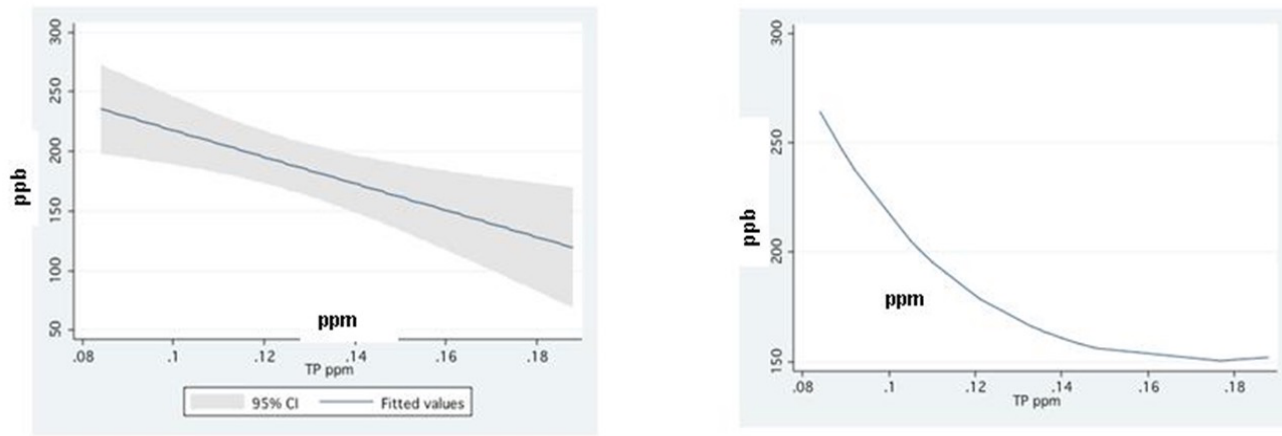
Figure 11. Annual averages of total phosphorus (TP) concentrations. In the Agmon effluent (ppb) vs. annual concentrations of TP in Jordan waters (ppm): linear prediction (95% CI) ( left ) and fractional polynomial regression ( right ) during